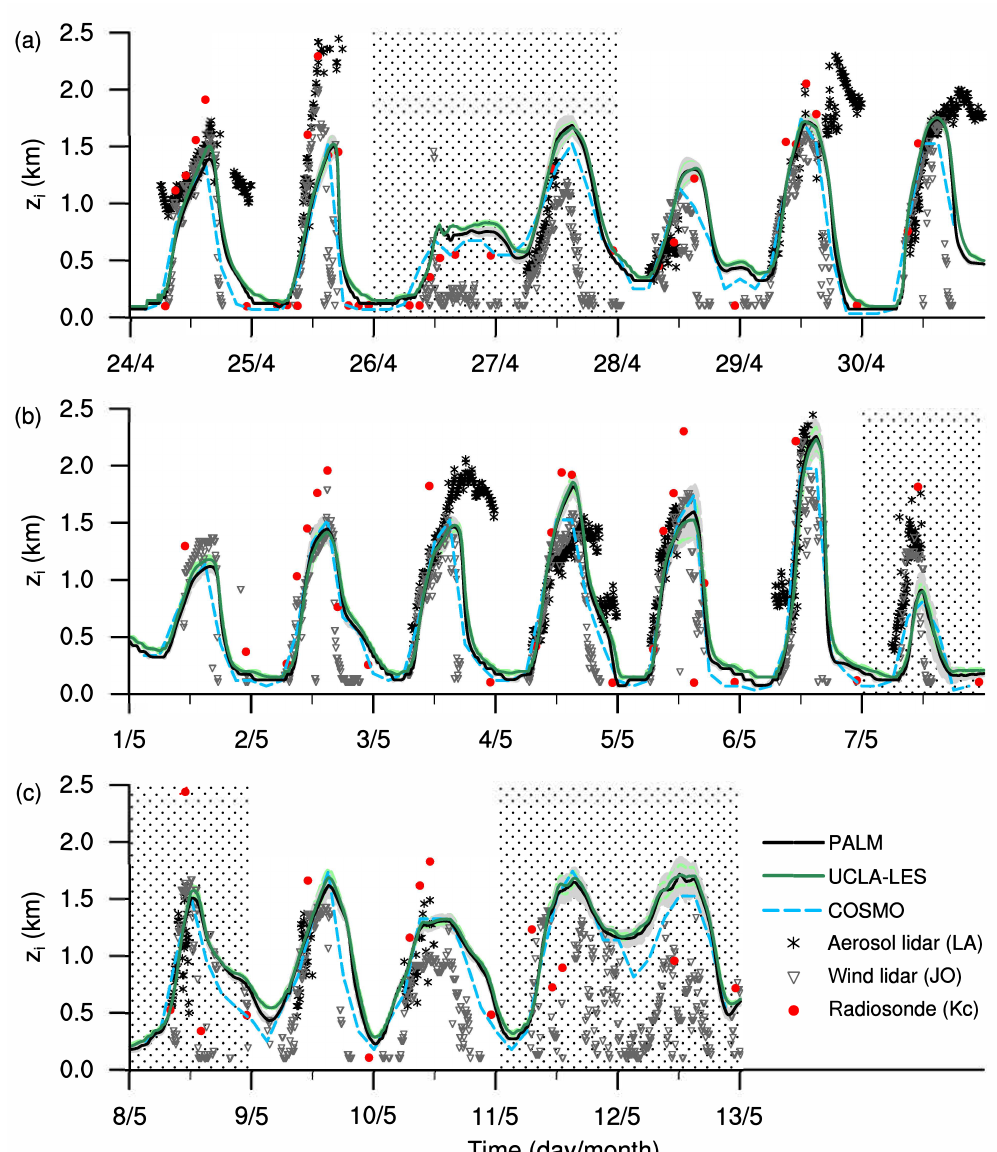
Figure 5. Temporal evolution of the boundary layer depth z i for the total 19-day period (grouped in weeks). z i is determined by means of the bulk Richardson number criterion in all three models (PALM, UCLA-LES and COSMO) and in the radiosonde data. A criterion based on the vertical velocity variance and detected aerosol layers is used for the wind lidar and aerosol lidar, respectively. Radiosondes were launched at the KITcube site; the wind lidar and aerosol lidar took measurements at the JOYCE and LACROS sites, respectively. Gray and green shading denote twice the standard deviation of z i in PALM and UCLA-LES, respectively. Stippled highlighting marks days with strong vertical forcing ( (cid:94) w SUB > 0.05ms − 1